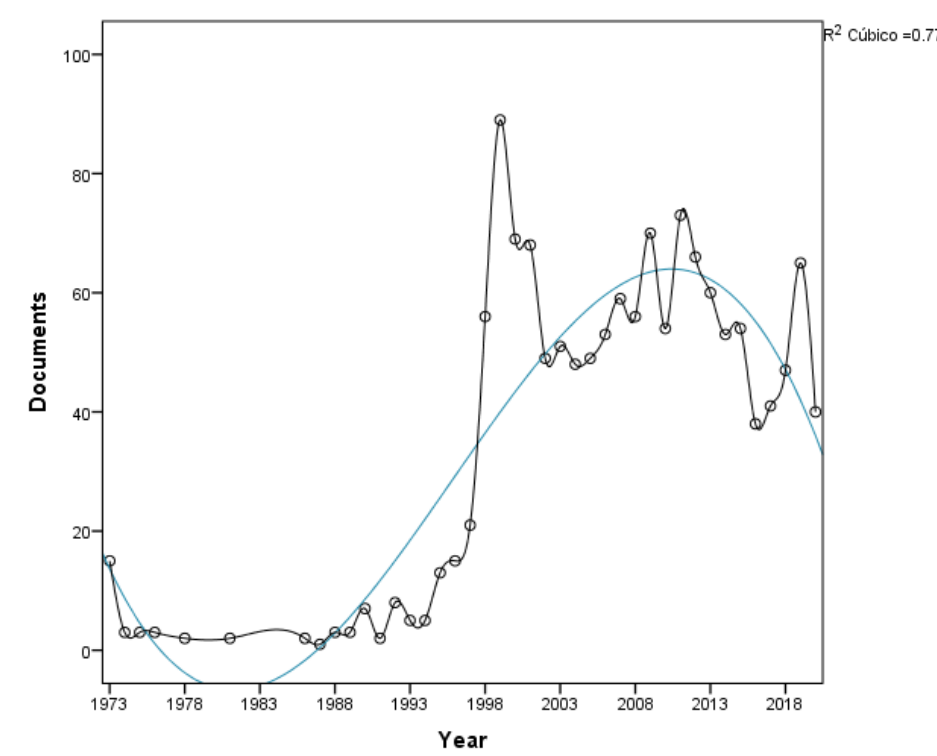
Figure 1. Behavior of publications on “biological pest control” and “microorganism” (1973–2020).